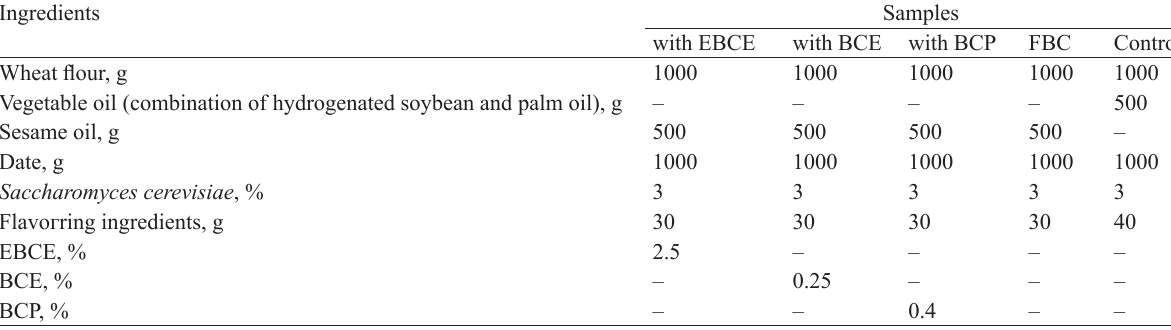
Table 1 Kolompeh